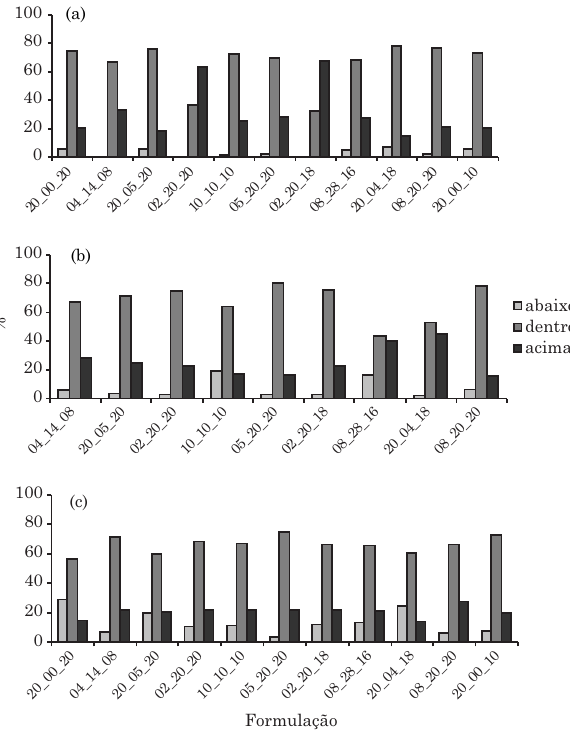
Figura 2. Frequências das conformidades das análises fiscais, por formulação, para o nitrogênio (a), fósforo (b) e potássio(c).